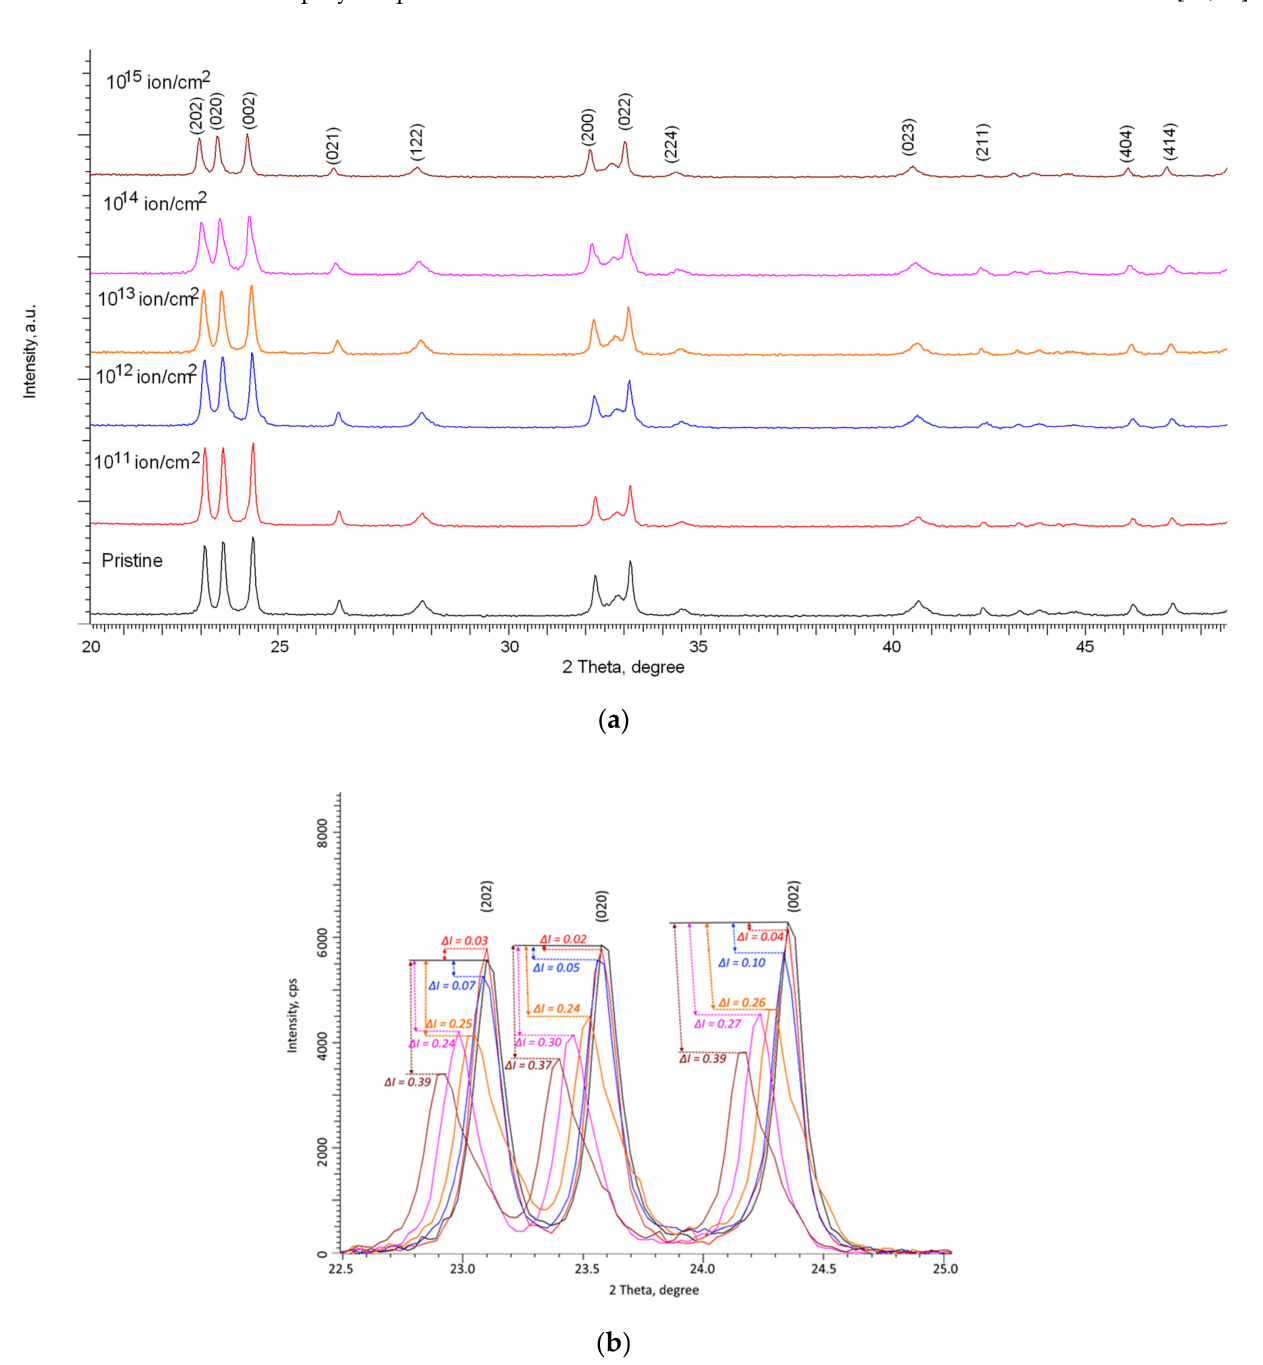
Figure 2. ( a ) Results of X-ray diffraction of the studied samples of WO 3 microparticles depending on the fluence of irradiation with Kr 15+ ions; ( b ) Detailed representation of the change in the intensity of the main diffraction reflections depending on the irradiation